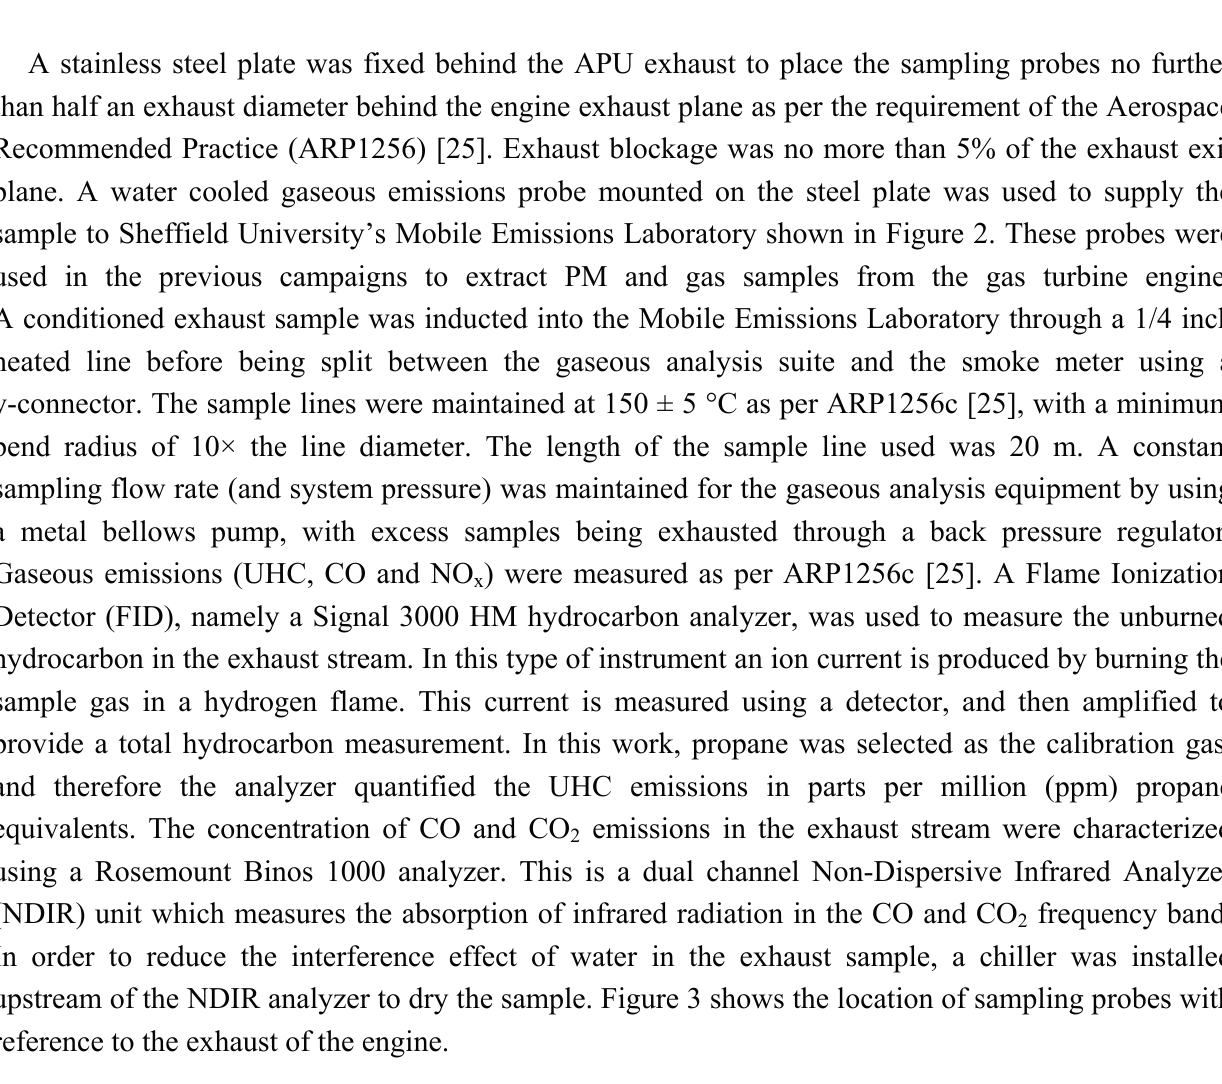
Figure 2. Mobile Emissions